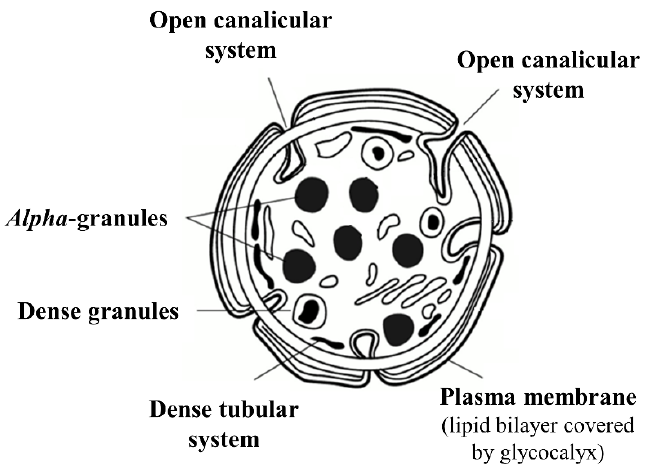
Figure 2. Schematic image of platelets. Resting platelets have asymmetrical distribution of phospho- lipids: the anionic phospholipids phosphatidylserine and phosphatidylethanolamine, responsible for binding many of the blood coagulation proteins, are sequestered in the inner leaflet of the mem- brane lipid bilayer facing the cytosol, whereas the electrically neutral phosphatidylcholine and sphingomyelin are exposed on the outer membrane leaflet. This arrangement prevents the mem- branes of resting platelets from supporting coagulation. When platelets become activated, the func- tion of the phospholipid transporters is altered, leading to transfer of anionic phospholipids on the outer membrane leaflet. Loss of this asymmetry provides a procoagulant surface for sequential ac- tivation of coagulation enzymes. The outer surface of resting circulating platelets is covered by a prominent glycocalyx that prevents spontaneous platelet aggregation. Platelets possess a plasma membrane-based open canalicular system connected with the extracellular space through a multi- tude of small pores that increases the platelet membrane’s surface area. A second platelet canalicular system that is not connected to the platelet’s exterior—the dense tubular system—serves as a store for calcium and for various enzymes involved in platelet activation. Platelet alpha and dense gran- ules contain a large number of substances critical for hemostasis, as well as for vasomotor function and immunity.